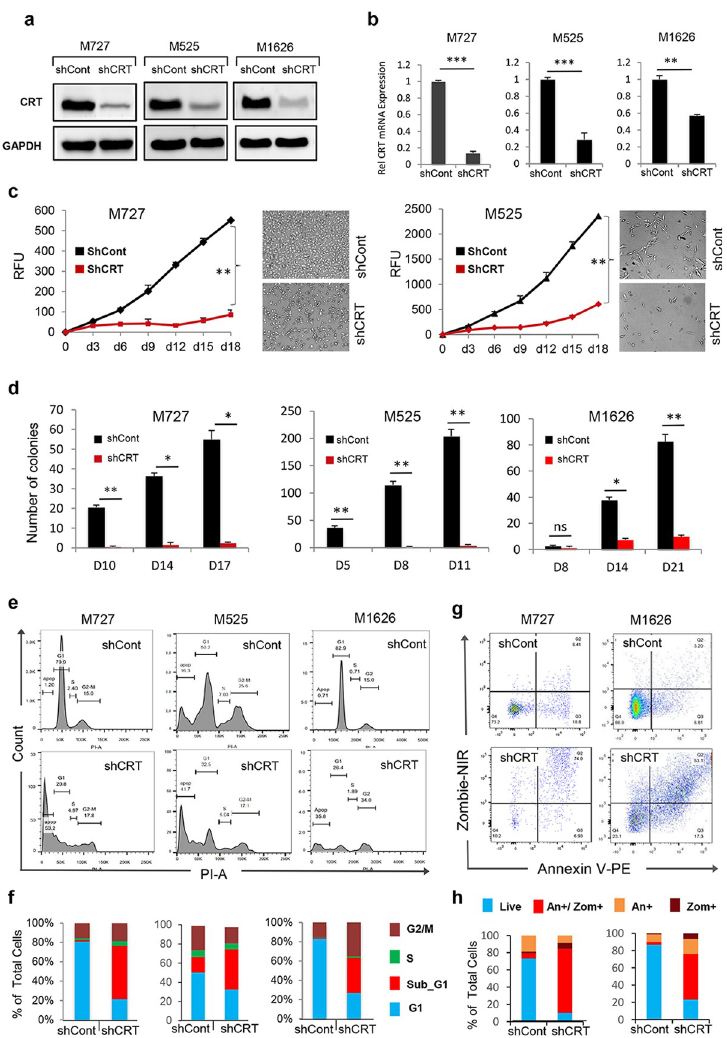
Fig 1. Down-regulation of CRT inhibits malignant properties of melanoma cells by activating cell-death response. Efficient down-regulation of CRT expression at the protein (A) and mRNA (B) levels following transduction of melanoma M727, M1626, and M525 patient-derived cells with the shCRT or shCont lentiviral vectors. Y-axis represents relative fold change in 2 ddcT values of CRT mRNA normalized to the control expression of 18 s rRNA. (C) Proliferation kinetics of patient-derived melanoma M727 and M525 cells each transduced with shCRT and shCont as measured by resazurin assay. (D) Number of colonies formed at indicated time periods by M727, M525, and M1626 melanoma cells following CRT knockdown compared with shCont transduced counterparts. (E, F) Cell cycle analysis of indicated melanoma cells using PI stain assay following CRT knockdown. The number of cells in various stages of the cell cycle was quantified measuring the area under the peaks (sub-G1, G1, S, G2 − M phases). (G, H) Analysis and quantification of the cell-death phenotype using viability Zombie/Annexin V stain assay following CRT knockdown. Underlying source data can be found in S1 Data. In all panels, unpaired Student t test was used to calculate p -values ( � P < 0.05, �� P < 0.005). All error bars indicate mean ± SD. CRT, calreticulin; GAPDH, Glyceraldehyde 3-phosphate dehydrogenase; NIR, Near-Infrared; RFU, Relative fluorescent unit; shCont, short hairpin RNA targeting Control; shCRT, short hairpin RNA targeting Calreticulin.